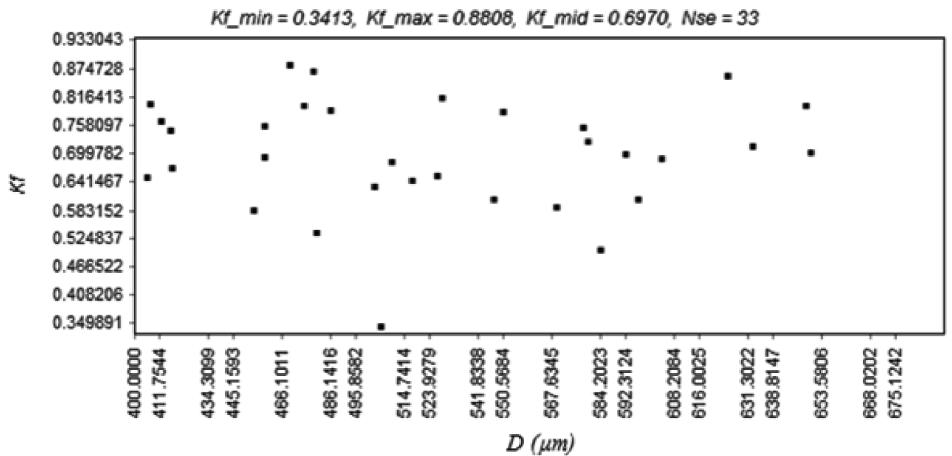
Fig. 4. Distribution of form coefficient versus particle diameter for characteristic Baltic seashore sand